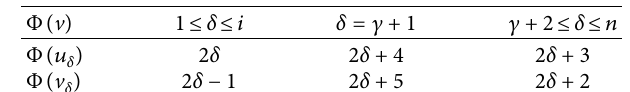
Table 11: Vertex labeling of Φ ( v